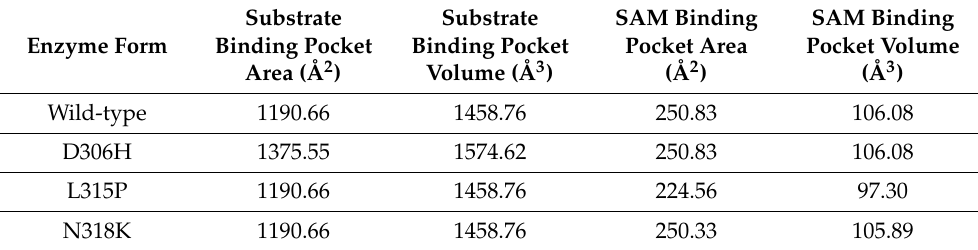
Figure 6. Change in the CASTp calculated binding pocket of wild-type PRMT5 versus mutants. ( A ) Wild type (left) and D306H mutant (right). ( B ) Wild type (left) and L315P mutant (right). Comparison of the available binding pocket (red) between the wild-type (left) and the mutant (right). The site of mutation + available binding pocket shift is indicated by the yellow ring. Protein structure is illustrated by the gray ribbon. Structure and pocket visualization were directly pulled from the CASTp server. Table 1. CASTp pocket analysis of PRMT5 mutations.